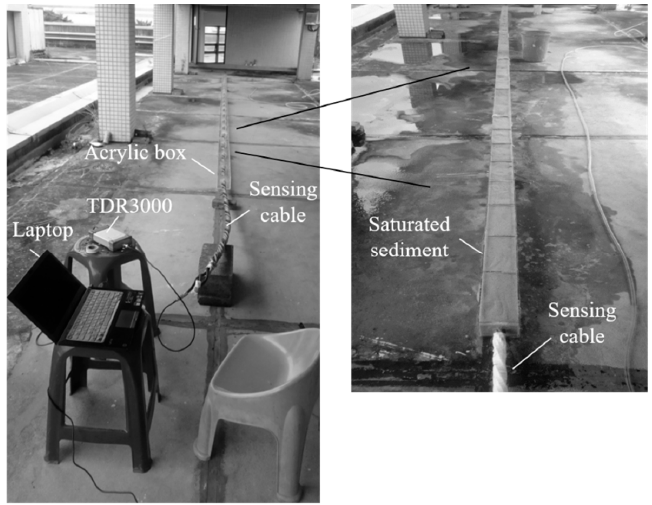
Figure 9. Photos showing the experimental setup of the full-scale scour simulation test.